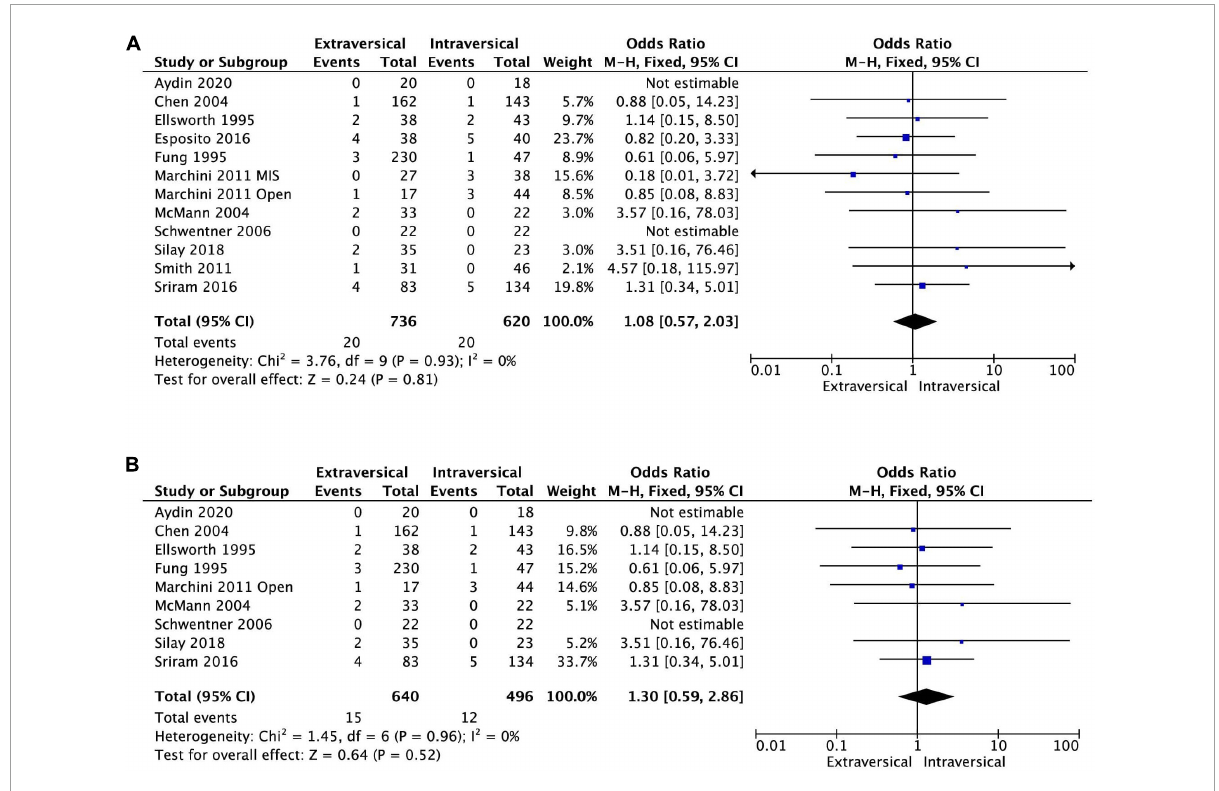
FIGURE4 Forest plot of persistence of reflux after (A) EVUR vs. IVUR in general, and after (B) open EVUR vs. open IVUR.